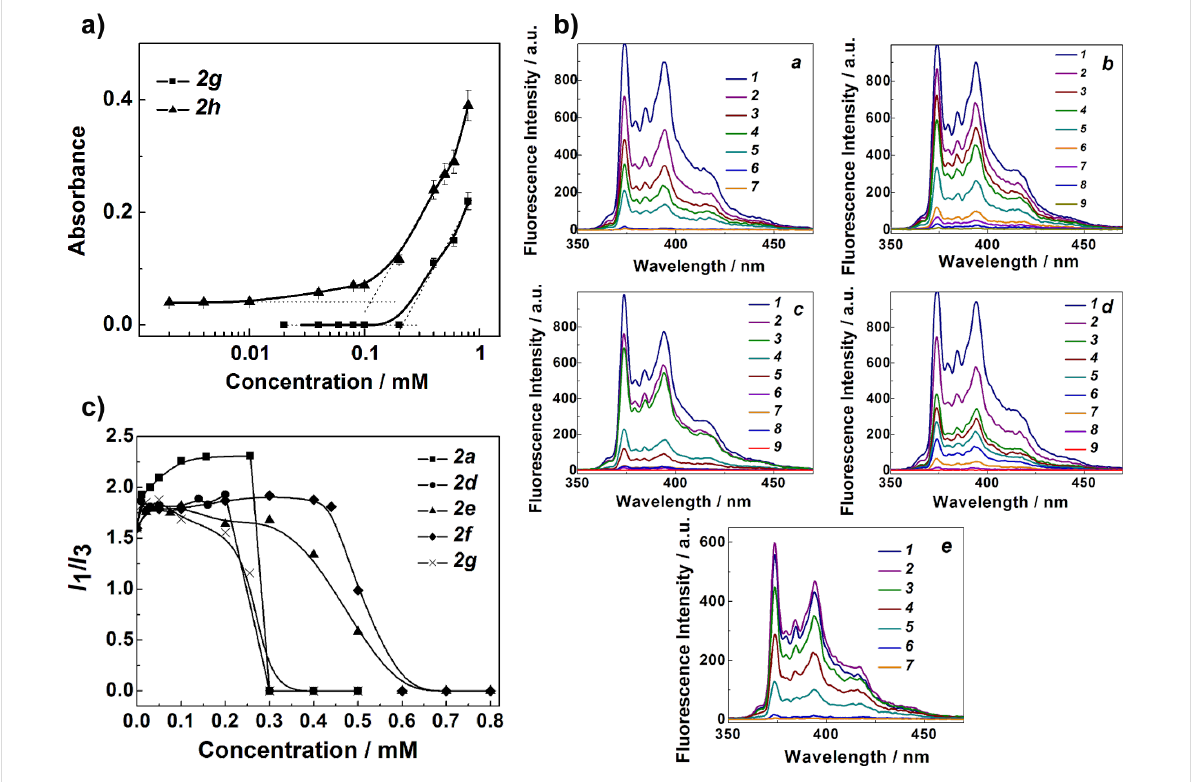
Figure 4: (a) Absorbance of the dye (Sudan I) at 495 nm as a function of the concentration of 2g and 2h in water/DMF (50% v/v) solution, 25 °C; optical length 0.1 cm. (b) Fluorescence of pyrene ( c pyrene = 1 × 10 − 6 M) in 2a (a), 2d (b), 2e (c), 2f (d), and 2g (e) in water/DMF (50% v/v) solution, 25 °C, c 2a (mM): 0 (1)–0.257 (7); c 2d (mM): 0 (1)–0.2 (9); c 2e (mM): 0 (1)–0.5 (9); c 2f (mM): 0 (1)–0.5 (9); c 2g (mM): 0.0097 (1)–0.255 (7). (c) Dependence of the intensity ratio ( I 1 / I 3 ) of the first and third peaks of pyrene on the 2a , 2d–g concentrations, c pyrene = 1 × 10 − 6 M, 25